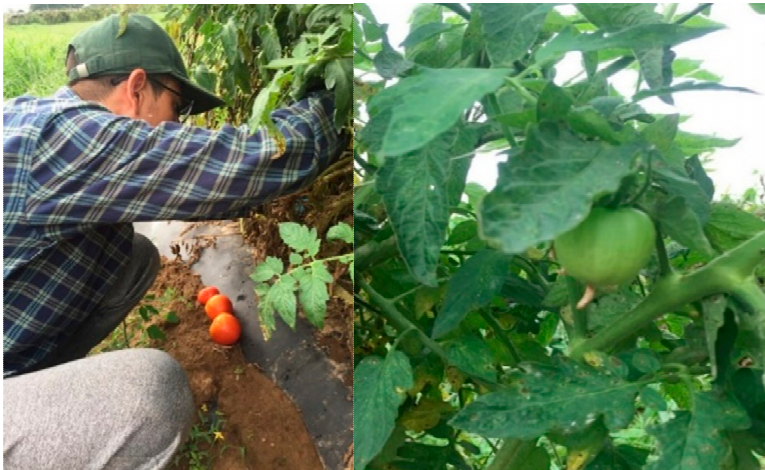
Figure 1. Tomato, Solanum lycopersicum var. marglobe grown in raised black plastic mulch.at Fayette County, Kentucky, USA.